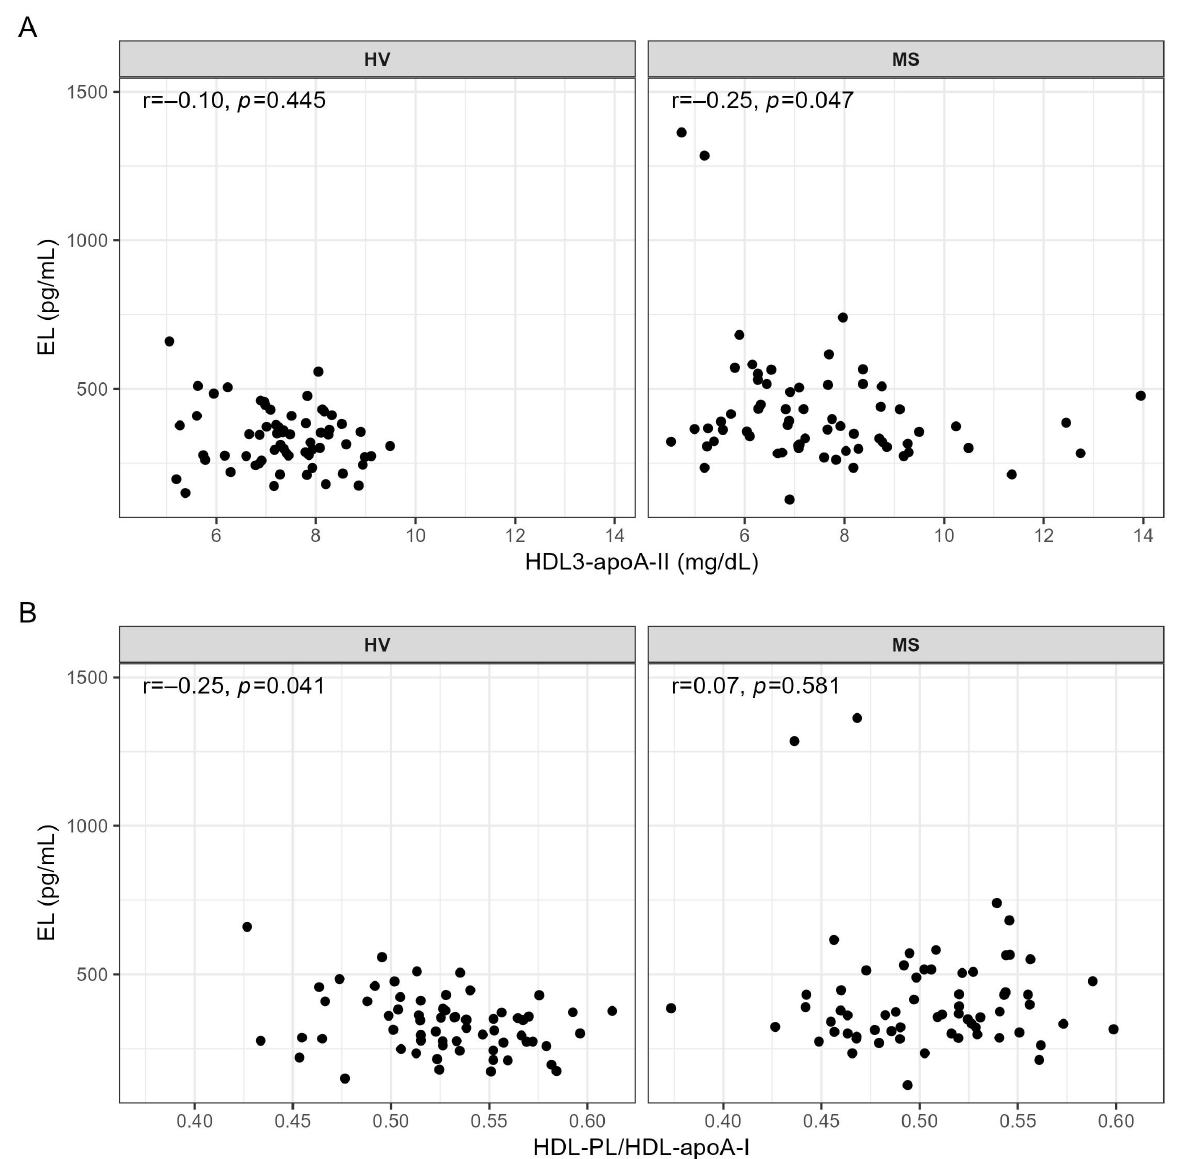
Figure 4. Correlations of EL with ( A ) HDL3-apoA-II and with ( B ) HDL-PL/HDL-apoA-I in HV and MS patients. Correlations were quantified using Spearman’s correlation coefficient. ApoA-I, apolipoprotein A-I; apoA-II, apolipoprotein A-II; EL, endothelial lipase; HDL, high-density lipopro- tein; HV, healthy volunteer; MS, metabolic syndrome patient; PL, phospholipid; r, Spearman’s cor- relation coefficient.